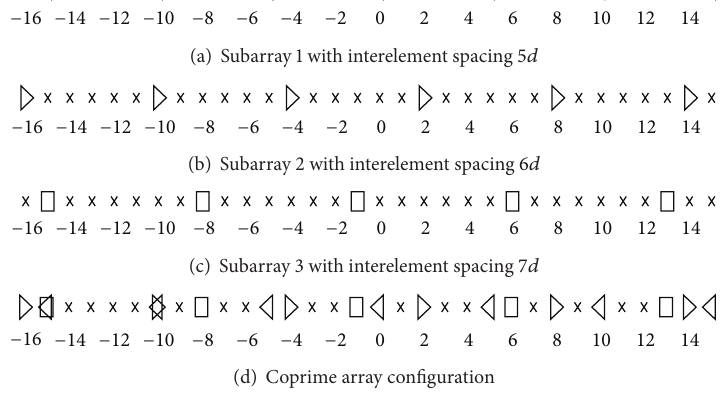
Figure 3: The sparse array configuration.